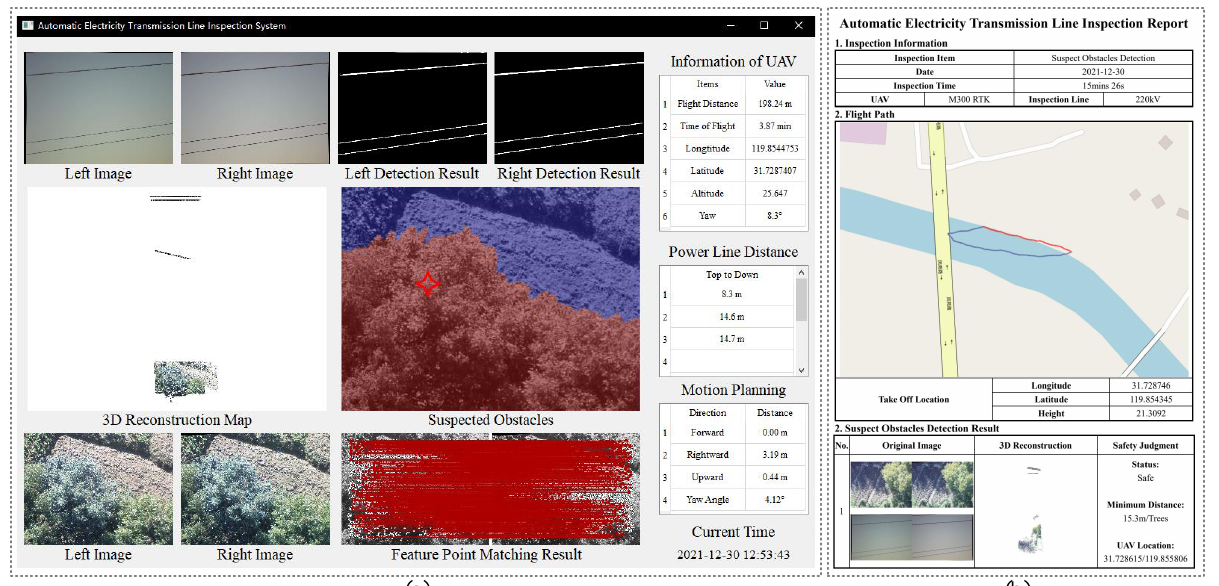
Figure 19. Interface and the generated patrol report of the inspection platform. ( a ) The visual interface of the automatic electricity transmission line inspection system; ( b ) The report of the automatic electricity transmission line inspection